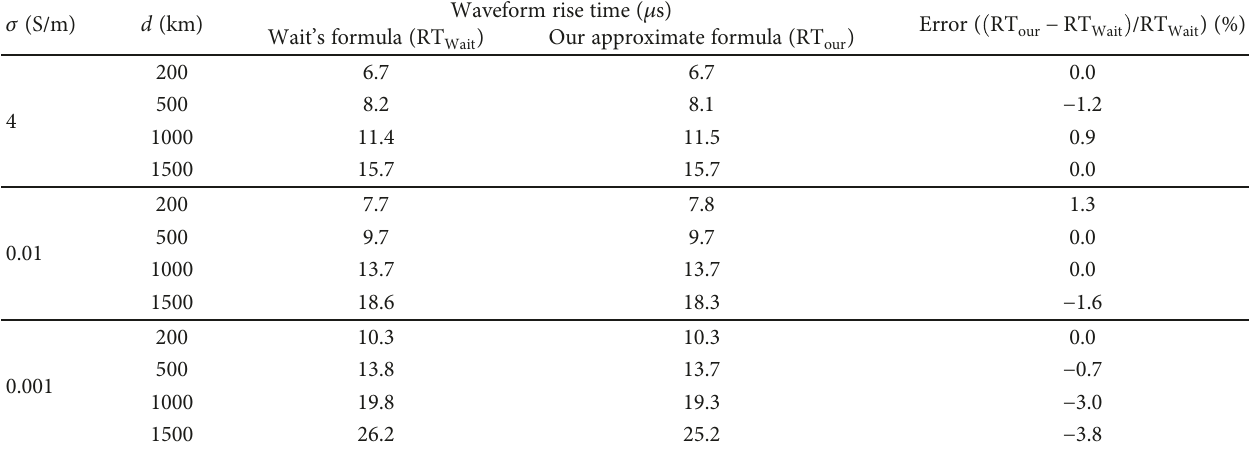
Table 2: Errors of the waveform rise time ( RT ) of the vertical electric fi eld calculated by our approximate method for di ff erent earth conductivity ( σ ) and propagation distances ( d ). σ (S/m) Waveform rise time (